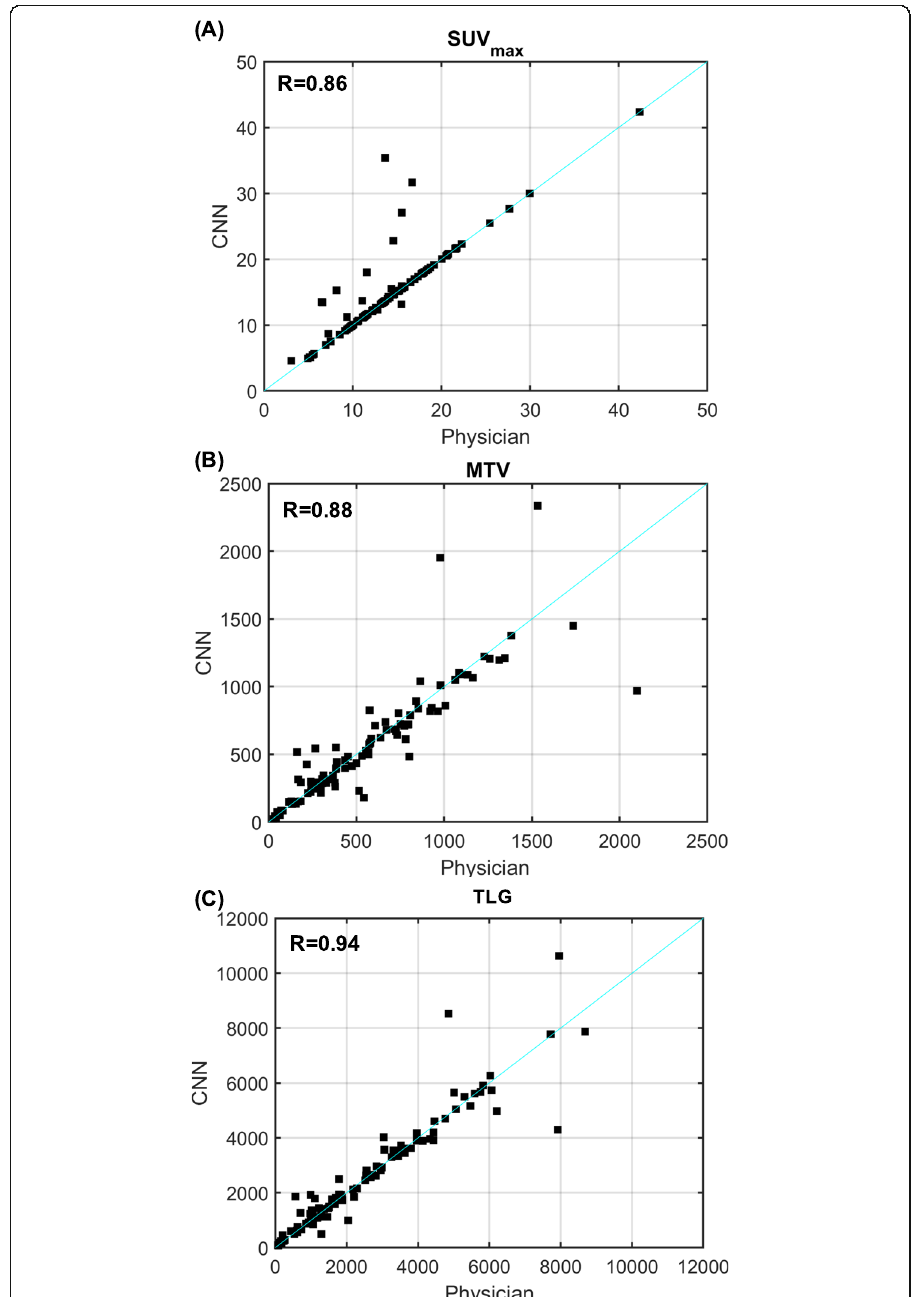
Fig. 3 Comparison of physician-based and automatically extracted features: SUV max ( a ), MTV ( b ), and TLG ( c ). Pearson correlation coefficients are shown in the top left corner of each plot, with unity lines